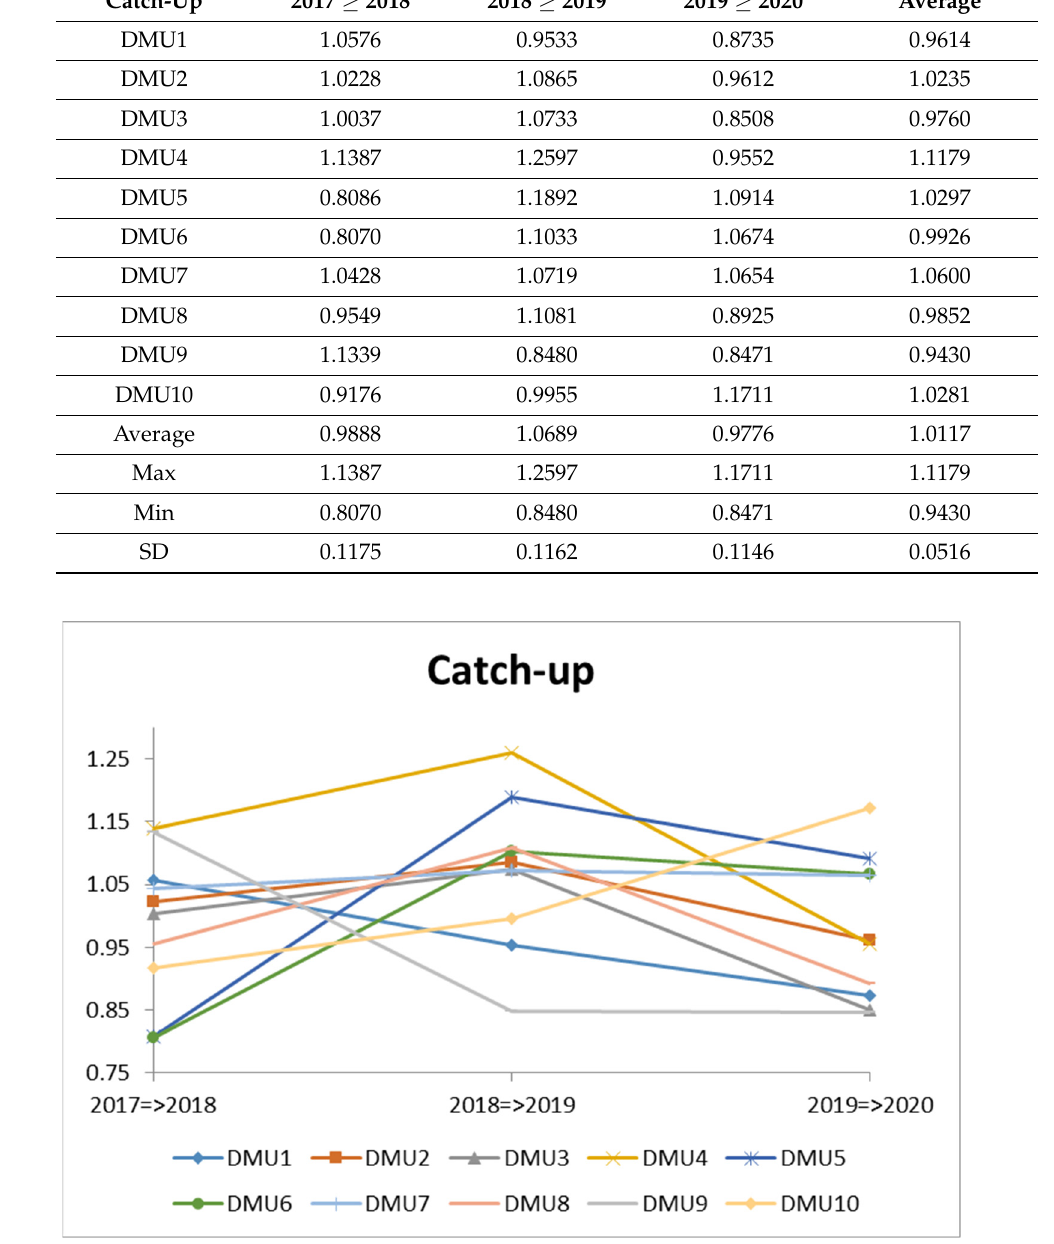
Table 7. Catch-up index of DMUs (2017–2020).